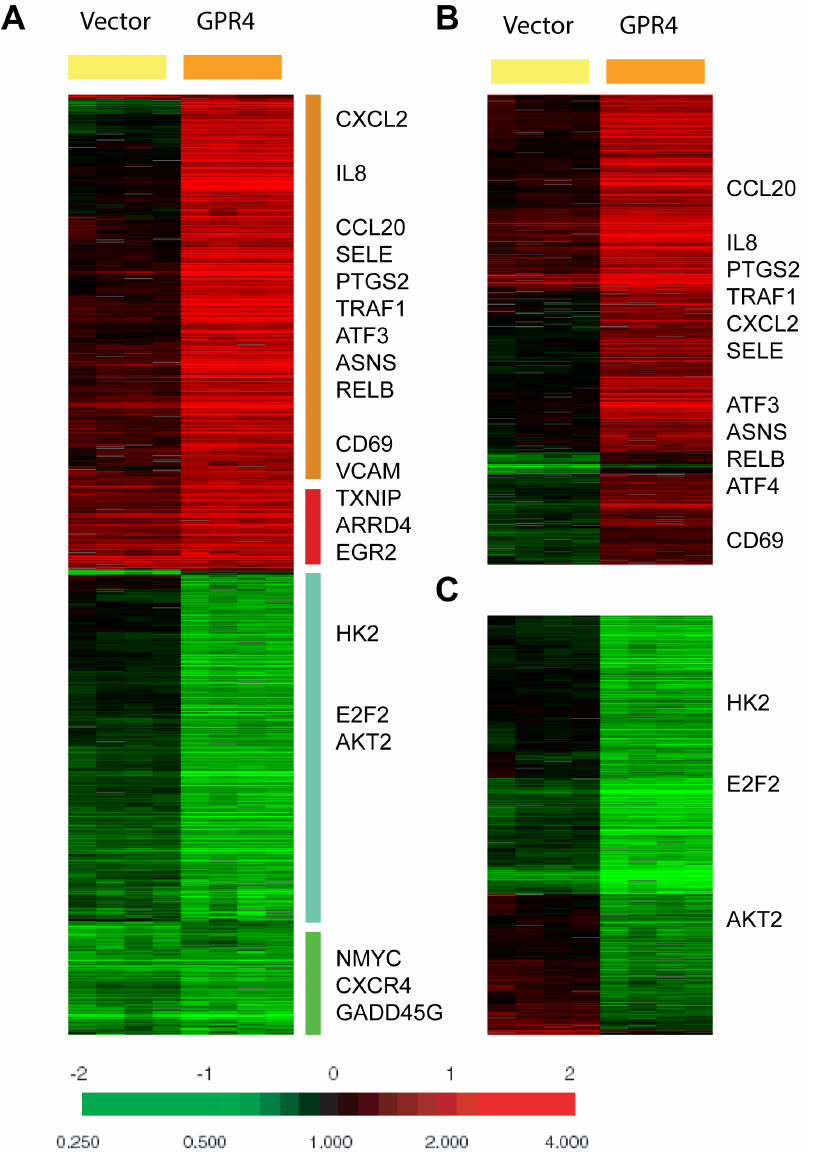
Figure 1. The global gene expression of acidosis response of HUVEC. (A) The gene expression response of HUVECs transduced with the control vector or the GPR4 expression construct is shown. 1208 probes were selected by the criteria of at least three observations with at least three fold changes and arranged by hierarchical clustering. Clusters of genes which are induced or repressed in a GPR4-depedent or -independent fashion are shown with the names of selected genes. (B, C) The gene expression responses of the probes selected by SAM to be 941 GPR4-induced (B) or 679 GPR4-repressed (C) are depicted with the names of selected genes shown.